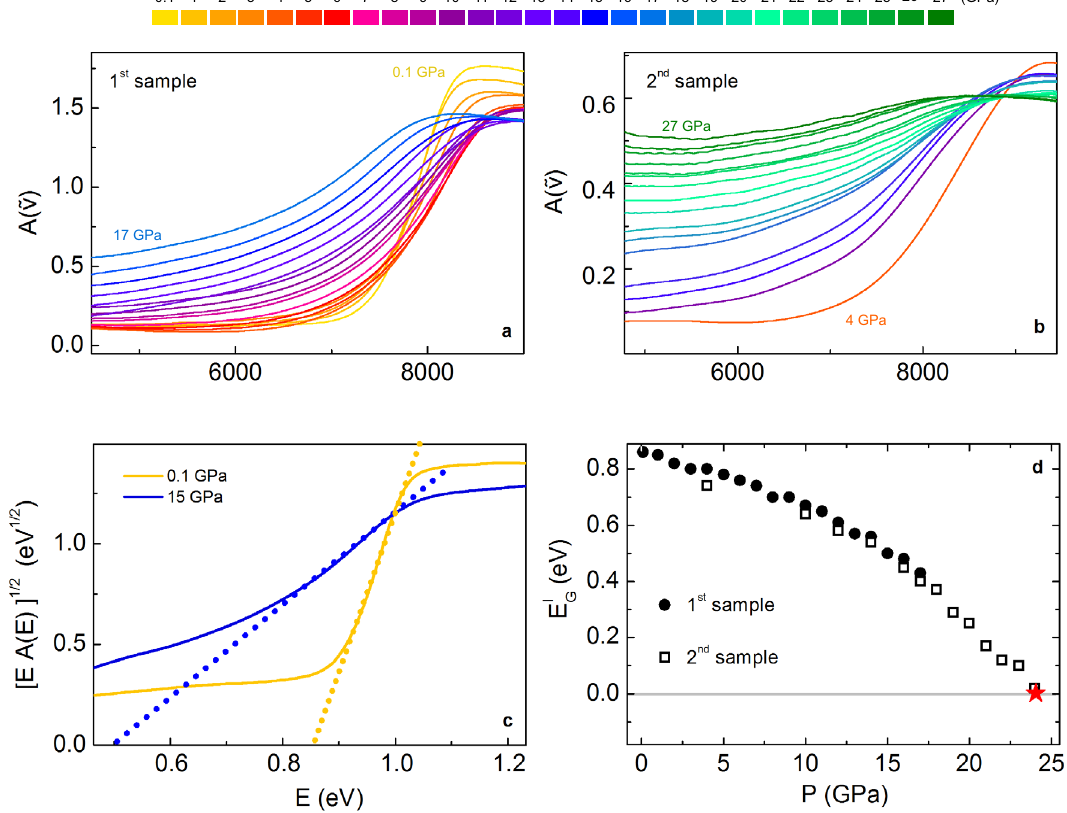
Figure 1. ( a ) Absorbance spectra collected in the first run over the 0.1–17 GPa range. ( b ) Absorbance spectra collected in the second run over the 4–27 GPa range. ( c ) Tauc plot at P = 0.1 GPa and P = 15 GPa and linear extrapolation (dotted lines) of the correspondent gap energies. ( d ) Energy gap as a function of pressure for the first (dots) and the second (open squares) run. The red star indicates the gap closing pressure, P